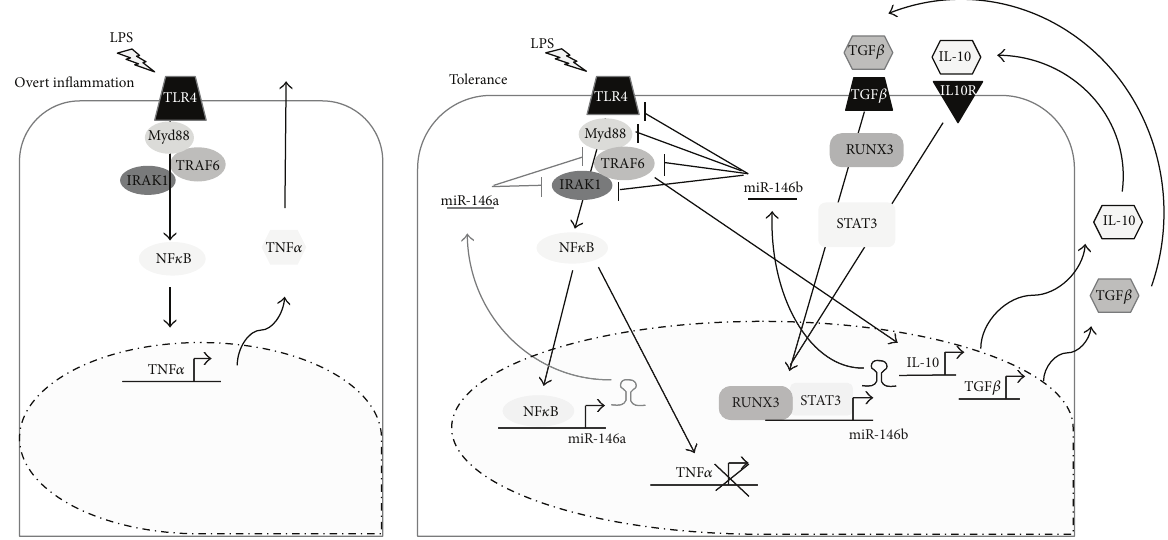
Figure 6: MiR-146 a/b effect on induction of endotoxin tolerance. During overt inflammation activation of the TLR4 signaling pathway triggers the induction of proinflammatory cytokines, including TNF 𝛼 , IL-6, CCL3, and IL-12. In the late phase of the inflammatory response, the induction of anti-inflammatory genes, including IL-10 and TGF 𝛽 , drives the expression of miR-146b through STAT3 and RUNX3, which negatively modulate TLR pathway at different steps, thus inducing